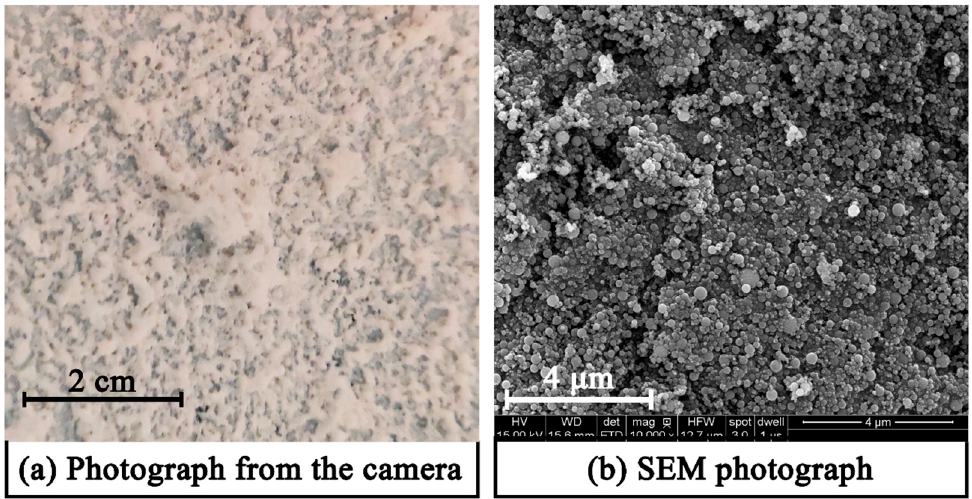
Figure 11. Photograph and SEM image of the aluminum dust explosion product.